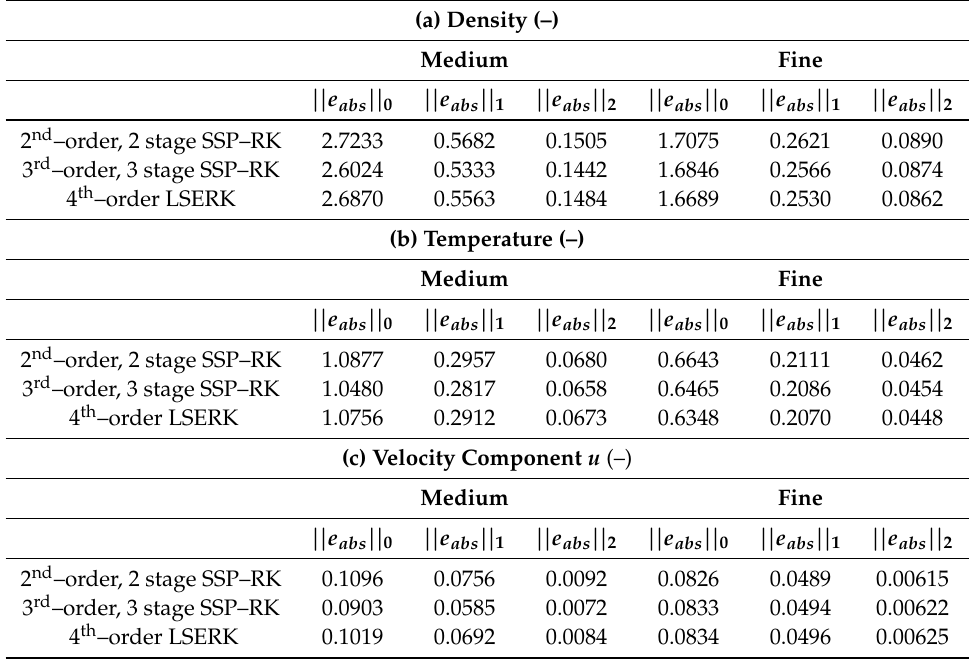
Table 6. L 0 , L 1 and L 2 norms of the absolute error between the results achieved with DG–FEM and reference data in [21]. Comparison between different explicit RK schemes using the medium and fine mesh. Results presented for density ( a ); temperature ( b ) in the centerline of the microchannel; and stream wise velocity ( c ) in the cross section x = 25 H . Results obtained at the final time T f = 80 µ s with Kn = 0.05 and N = 1.